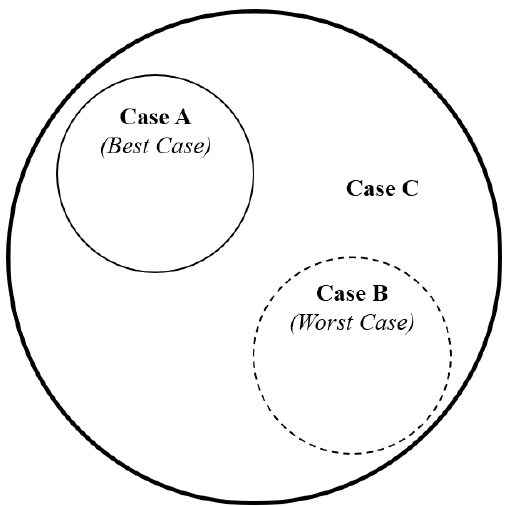
Figure 6. Constellation of all possible mismatching scenarios.